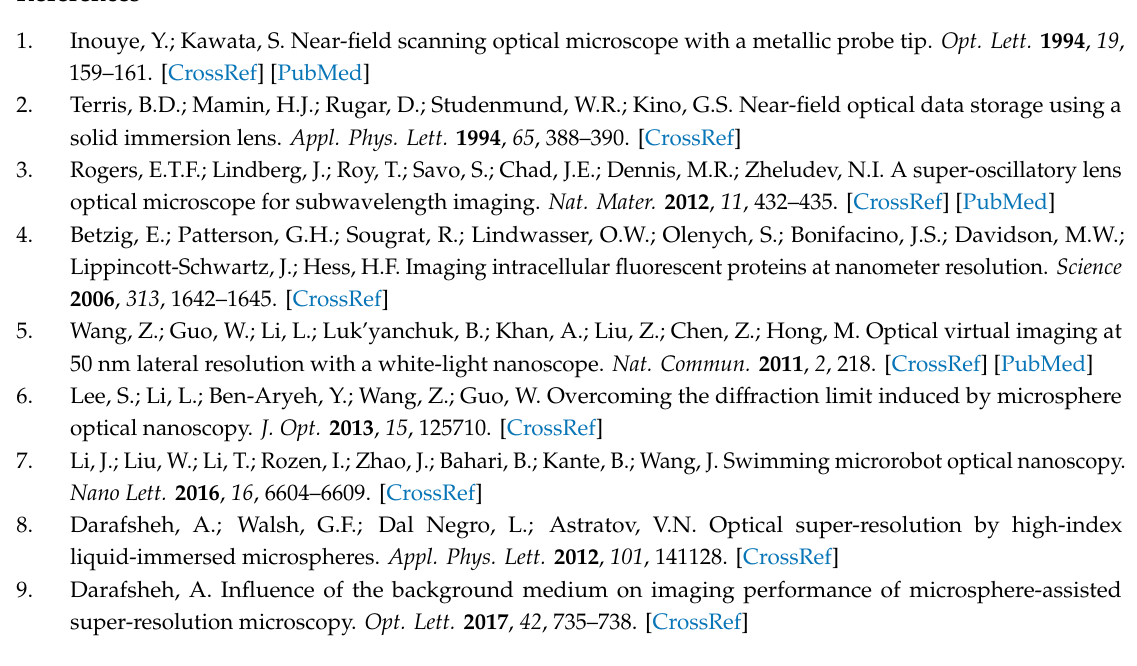
Figure S1: Axial (a) and radial (b) trapping e ffi ciency for a coated BTG sphere with a core radius of 2.5 µ m, as the SiO 2 coating thickness varies; Figure S2: Relative change of the FWHM and maximum optical intensity of PNJs for a 2.5 µ m-core-radius BTG sphere with di ff erent SiO 2 coating thickness. Table S1: Optical trapping e ffi ciency and PNJ property of five di ff erent microspheres in water. Video S1: Axial trapping e ffi ciency with varied PS coating thickness; Video S2: Radial trapping e ffi ciency with varied PS coating